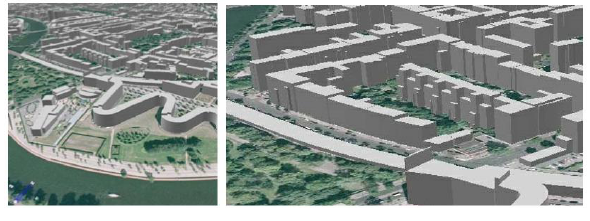
Figure 1 Berlin virtual 3D city model (source: Jürgen Döllner, 2006)